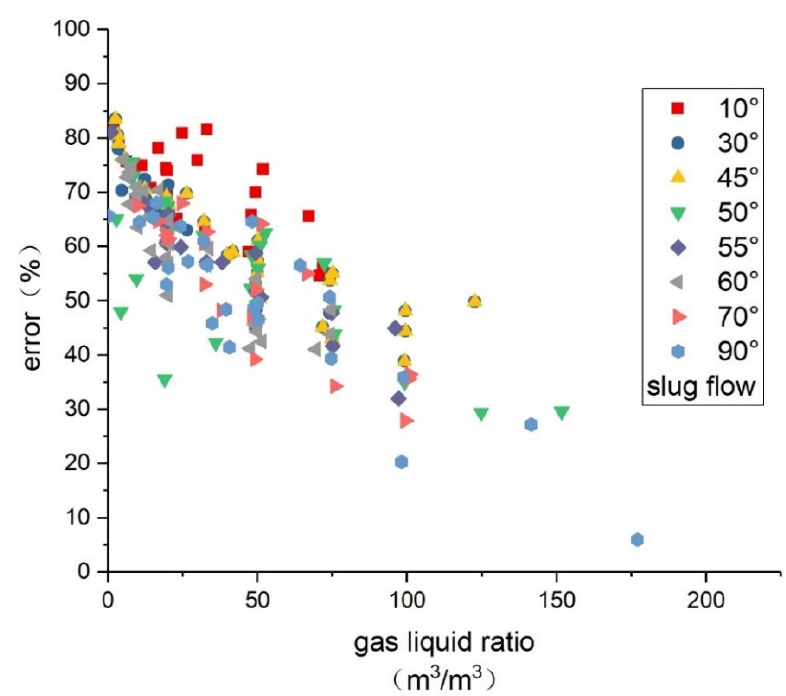
Figure 15. The error between calculated values and actual values in slug flow. The Froude number (FR) is a dimensionless scalar in fluid mechanics; it is the ratio of the fluid kinetic energy to potential energy. When fr > 1, the water depth is small, and the velocity is turbulent. Similarly, when fr < 1, the velocity is slow, and the water depth is large. Similarly, the Reynolds number (Re) is also a classical dimensionless number used to characterize fluid flows in fluid mechanics. The gas–liquid velocity ratio is a more intuitive reaction gas–liquid ratio. In addition to the gas–liquid velocity ratio, the Froude